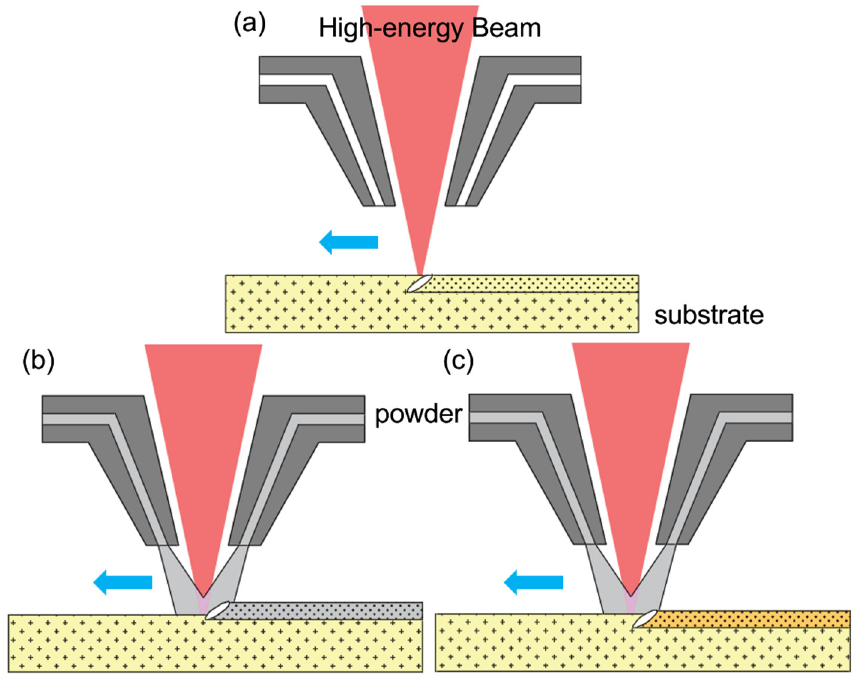
Figure 1. Schematic of processing method: ( a ) High-energy beam remelting; ( b ) High-energy beam cladding; ( c ) High-energy beam alloying.